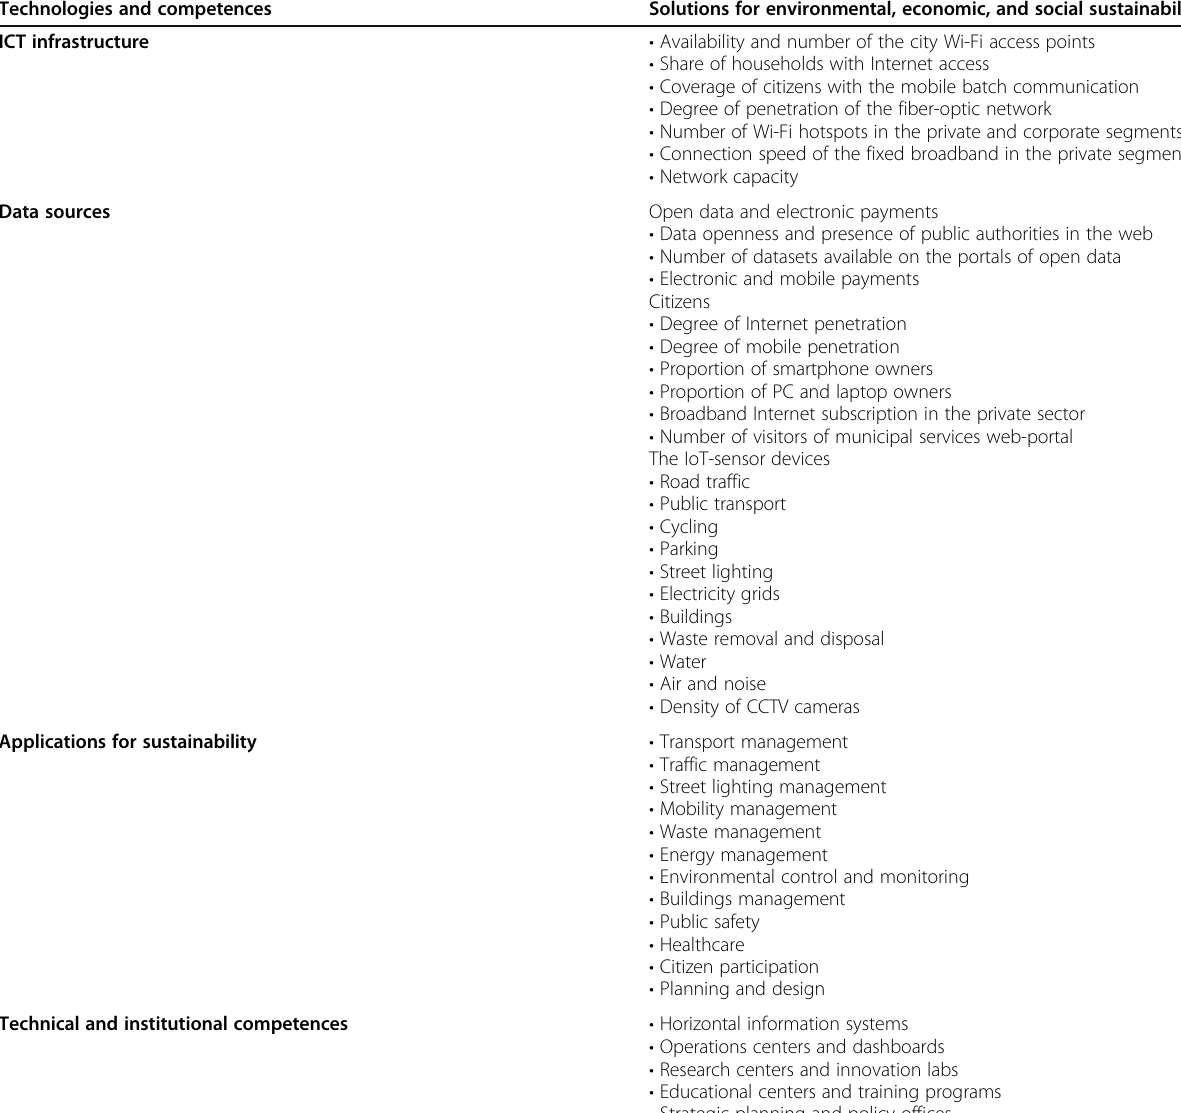
Table 4 The key dimensions and solutions of the data-driven smart city for achieving sustainability Technologies and